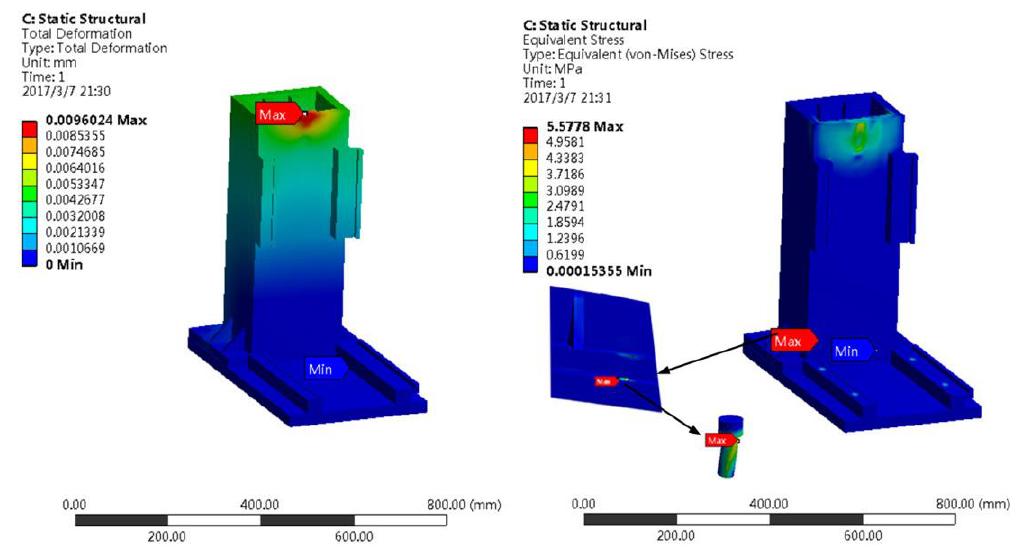
Figure 11. Static deformation and stress at the lower limit of the integral structure.